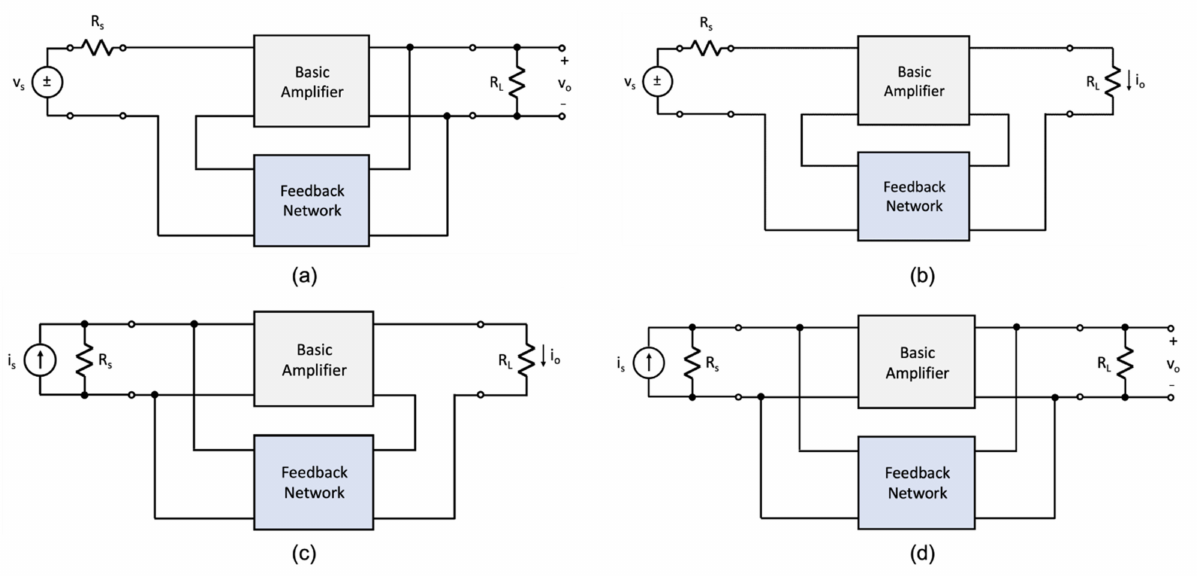
Figure 2. The four noncompliant single-loop feedback topologies incorporated with circuits: ( a ) voltage-mixing/voltage-sensing, ( b ) voltage-mixing/current-sensing, ( c ) current-mixing/current- sensing, and ( d ) current-mixing/voltage-sensing.